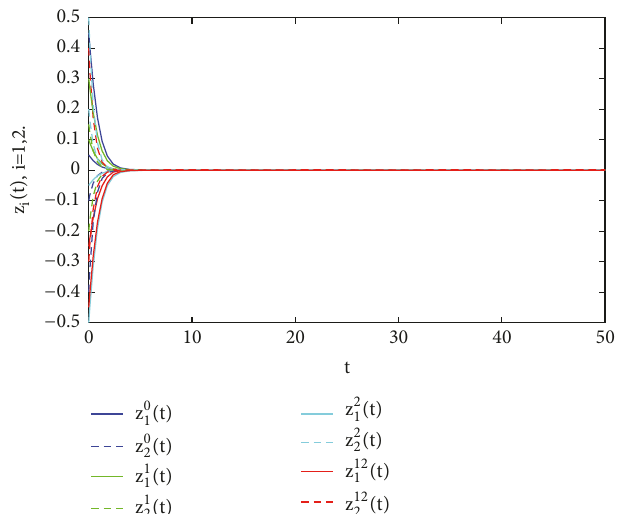
Figure 5: Synchronization errors 𝑧(𝑡) = 𝑦(𝑡) − 𝑥(𝑡)